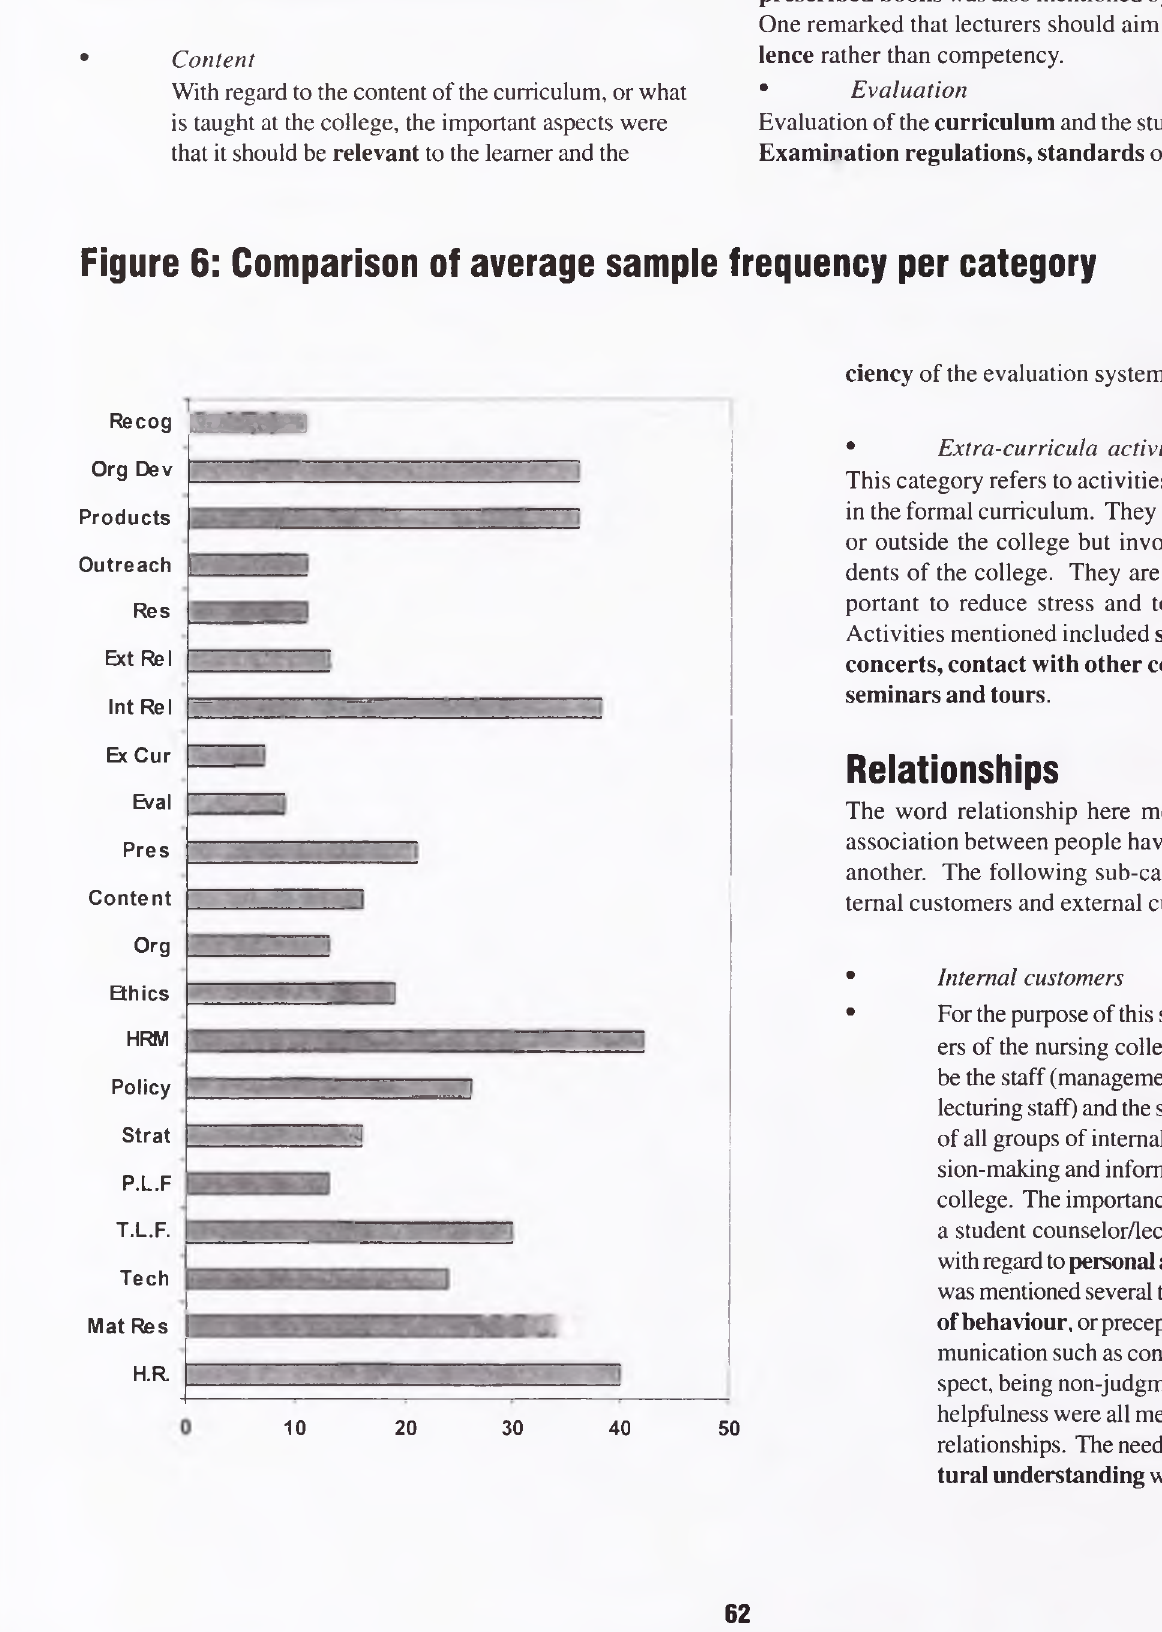
Figure 6: Comparison of average sample frequency per